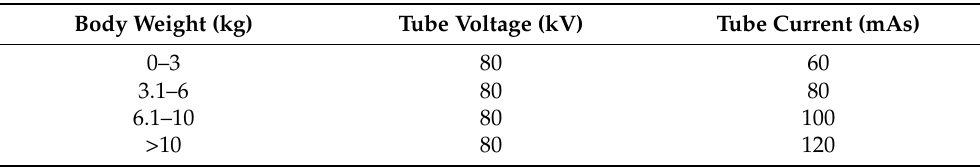
Table 1. Low-dose prospective ECG-gated cardiac CT parameters with weight-based radiation dose